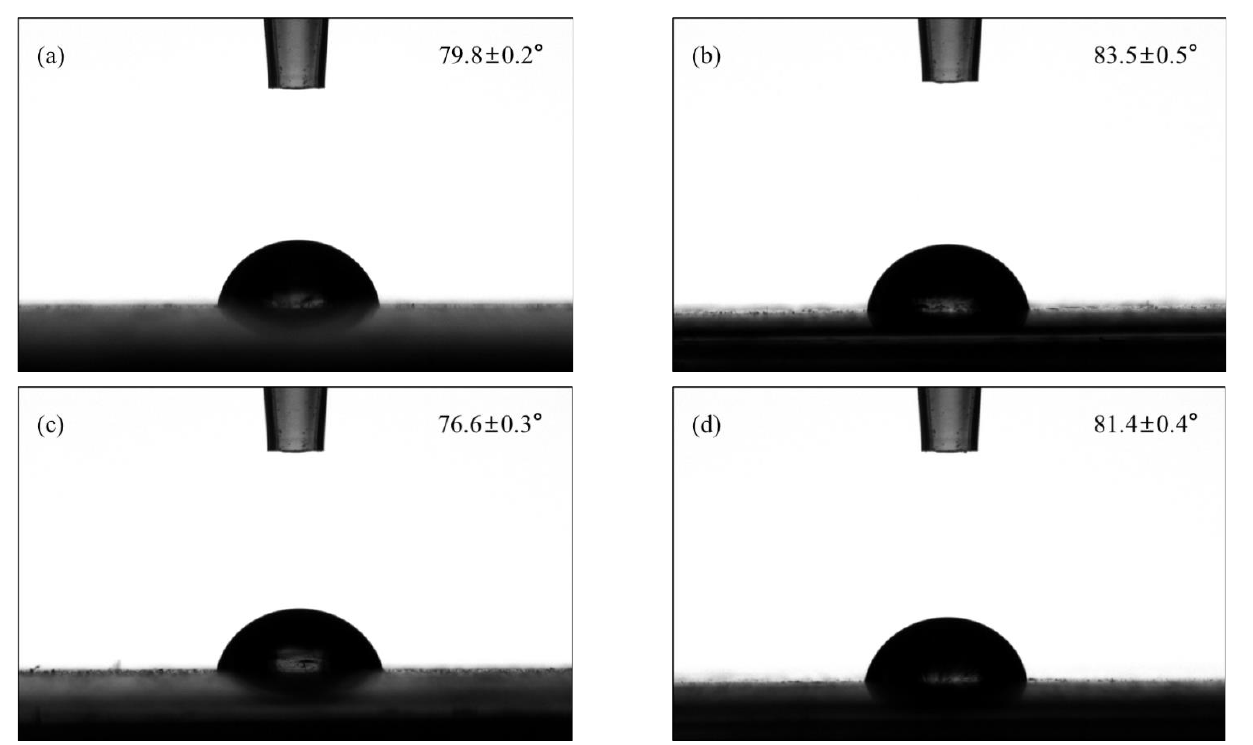
Figure 10. The water contact angle for various coated samples ( a ) blank sample, ( b ) C 8 mimPF 6 , ( c ) CNCs, ( d ) C 8 mimPF 6 -CNCs.